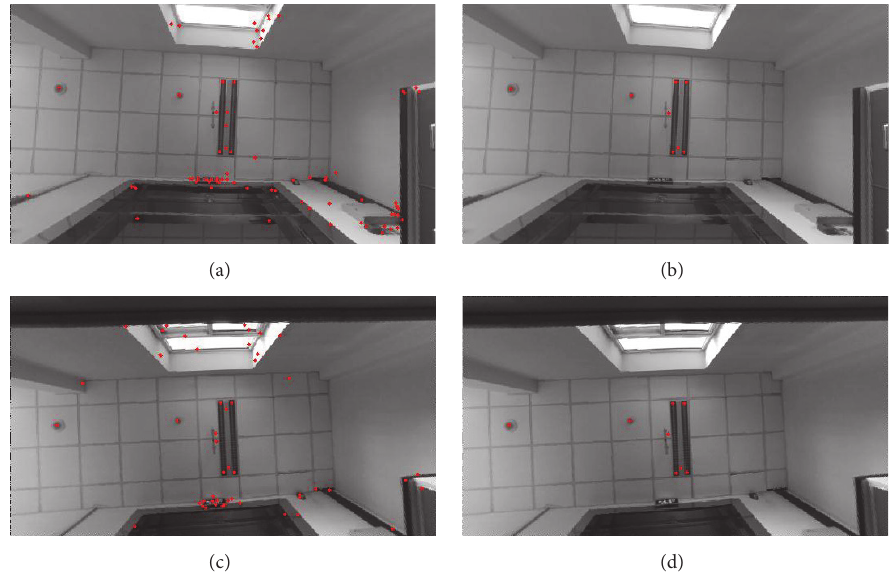
Figure 6: The image processing of ceiling feature point detection (red points are the feature points). (a) Original feature points in frame 𝐴 , (b) ceiling points detecting result in frame 𝐴 , (c) original feature points in frame 𝐵 , and (d) ceiling points detecting result in frame 𝐵